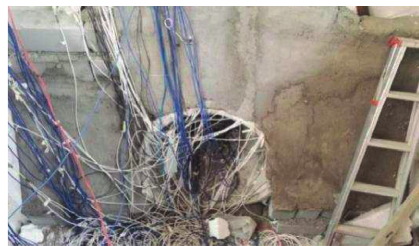
Figure 13: Oval tunnel opening map.